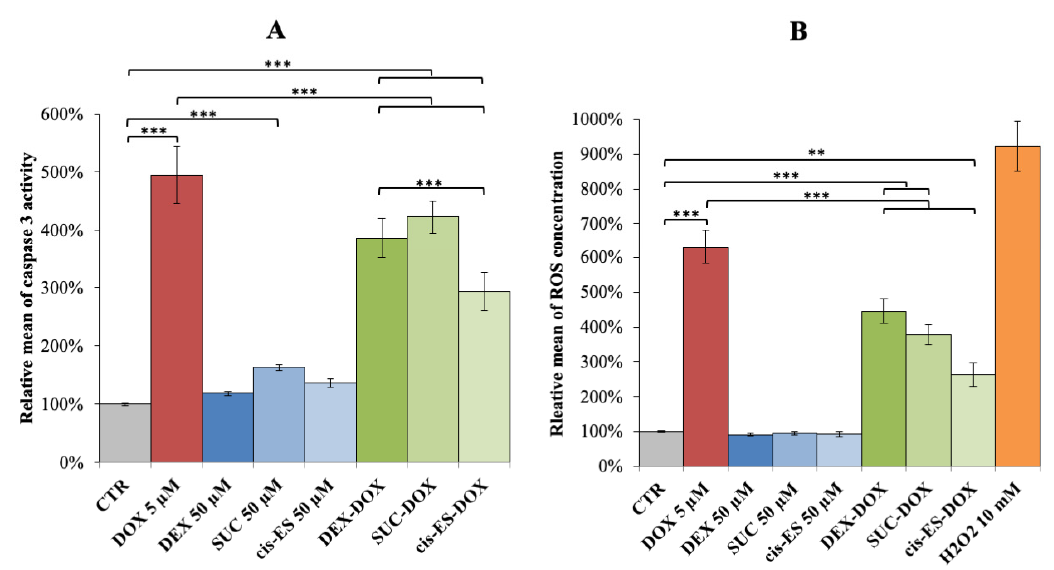
Figure 3. ( A ) Relative mean ( +/ − SEM) of caspase 3 activity after 4 h of exposure to DOX and cardioprotective compounds administrated alone or 30 min prior to DOX exposure. ( B ) Relative mean ( +/ − SEM) of the reactive oxygen species (ROS) concentration after 2 h of exposure to DOX and cardioprotective compounds administrated alone or 30 min prior to DOX exposure. ANOVA one-way with multiple comparisons: ** p -value < 0.01 and *** p -value <